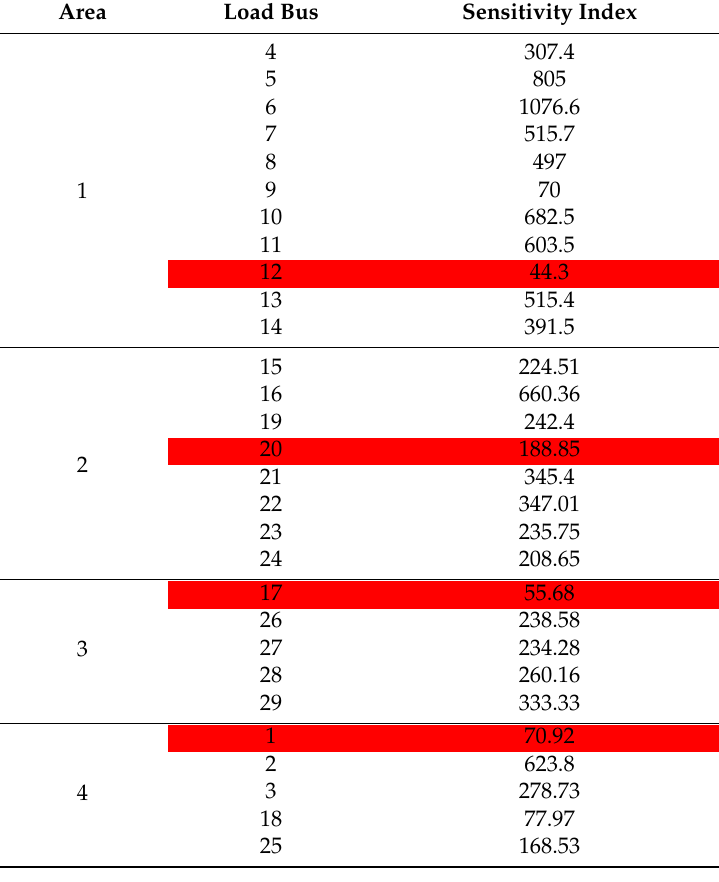
Table 4. V-Q sensitivity indices for all area buses.